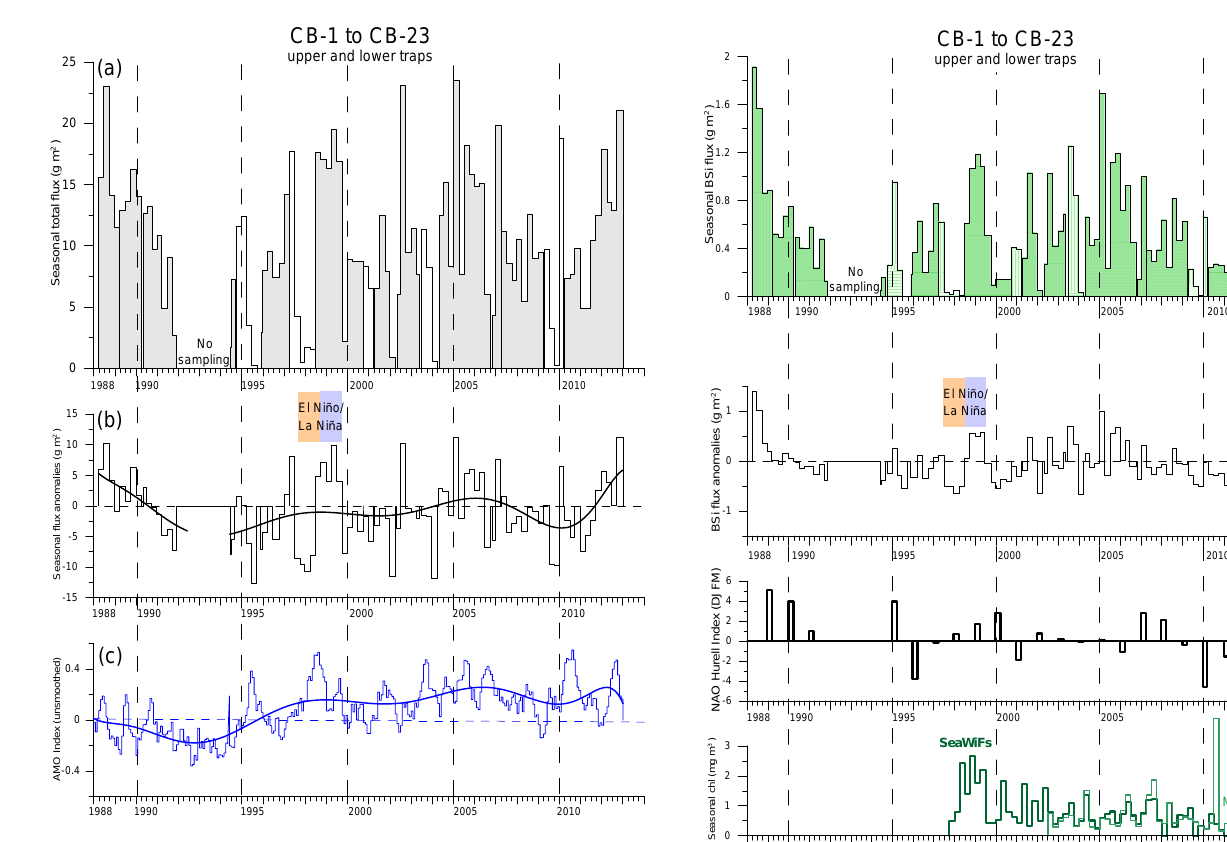
Figure 5. (a) Total mass fluxes of the lower traps (grey-shaded). Gaps were filled with upper trap data (light grey bars). Deviations of the seasonal total mass fluxes from the long-term seasonal means (anomalies), fitted with a 9-order polynomial (b) . (c) Atlantic Multi- decadal Oscillation (AMO) Index based on monthly SST fitted with a 9th-order polynomial fit (dashed blue line). The strong ENSO cy- cle 1997–1999 with a warm El Niño and a cold La Niña phase is indicated.